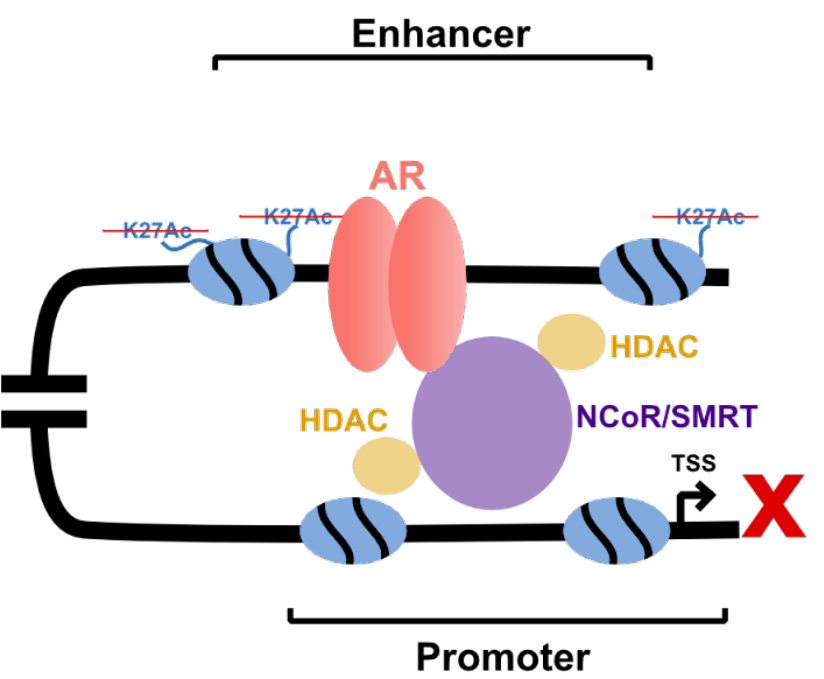
Figure 3. AR-mediated gene repression. AR is bound by corepressors such as NCoR/SMRT, creating a corepressor complex and facilitating HDAC activity to suppress gene activation.